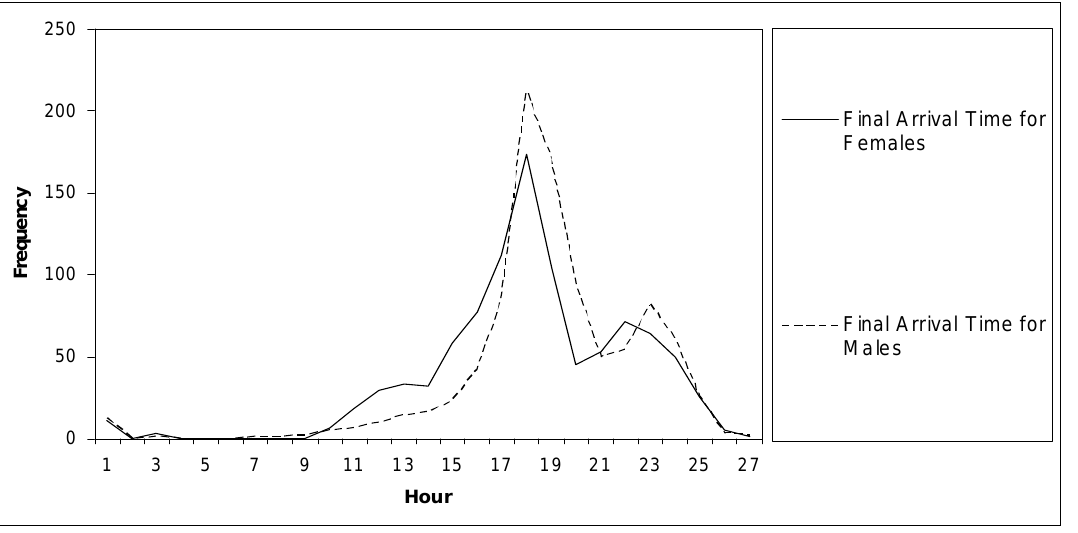
Figure 3. Distribution of final arrival at home for females and males Table 4. Number and Proportion of Observations by Activity Pattern &